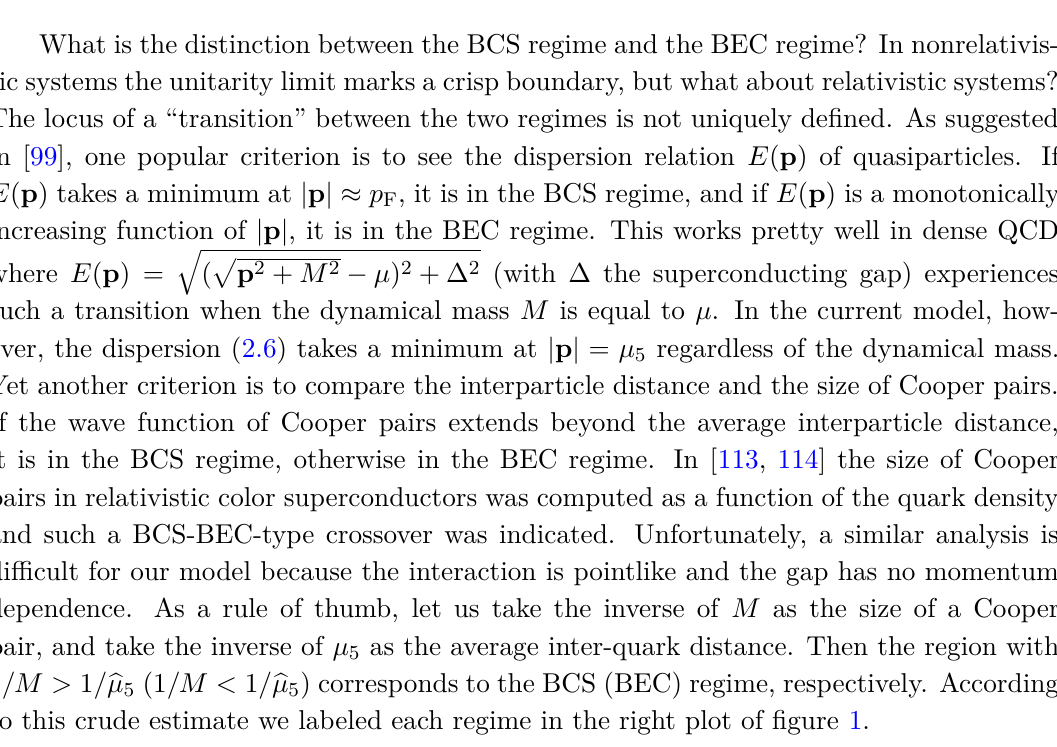
µ 5 /M ) . The white curve indicates log( b